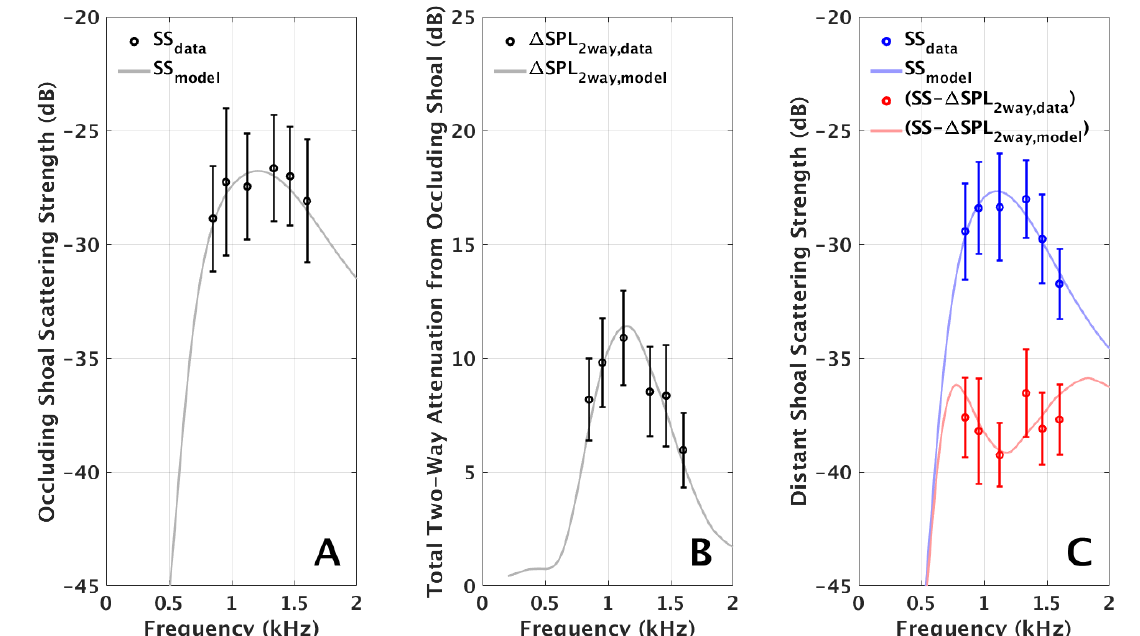
Figure 4. Theoretical consistency is demonstrated between concurrently measured backscattering strength ( A ) and attenuation due to multiple forward scattering ( B ) from the occluding shoal shown in Figure 1. Attenuation is measured as the decrease in scattered returns from a distant shoal after the occluding shoal moves into the propagation path, that is the difference between the red and blue data in ( C ). Modeled scattering strength and total attenuation (grey lines in A and B , respectively) assume the same fish shoal parameters and fit the data within one standard deviation. Scattering strength and attenuation of the occluding shoal ( A and B ) are modeled using the following estimated parameters: mean shoal depth z 0 = 60 m, shoal thickness H = 40 m, neutral buoyancy depth z nb = 0 m, areal number density n A = 2.4 fish/m 2 and horizontal extent r h = 1.1 km. Scattering strength of the distant shoal (blue line in C ) is modeled using the following estimated parameters: mean shoal depth z 0 = 85 m, shoal thickness H = 50 m, neutral buoyancy depth z nb = 10 m and areal number density n A = 1.1 fish/m 2